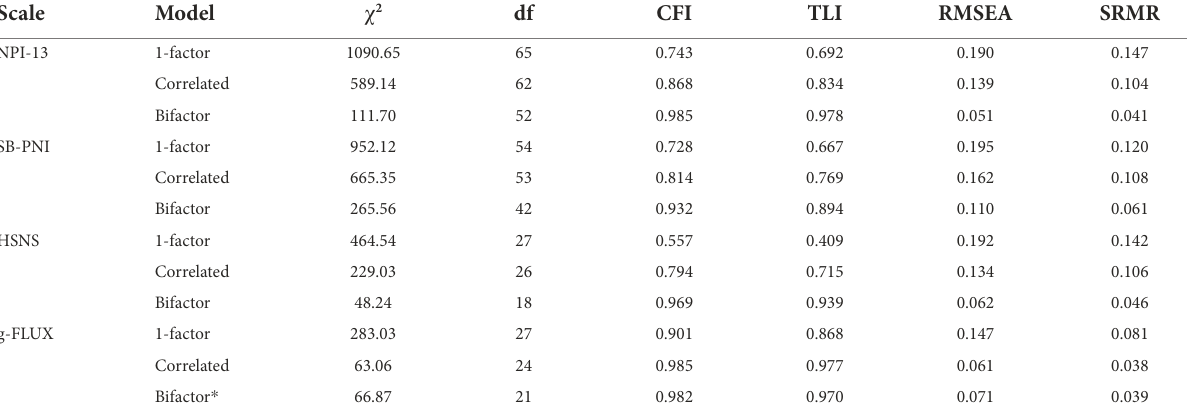
TABLE 1 CFA fit indices of single factor, correlated factors and bifactor